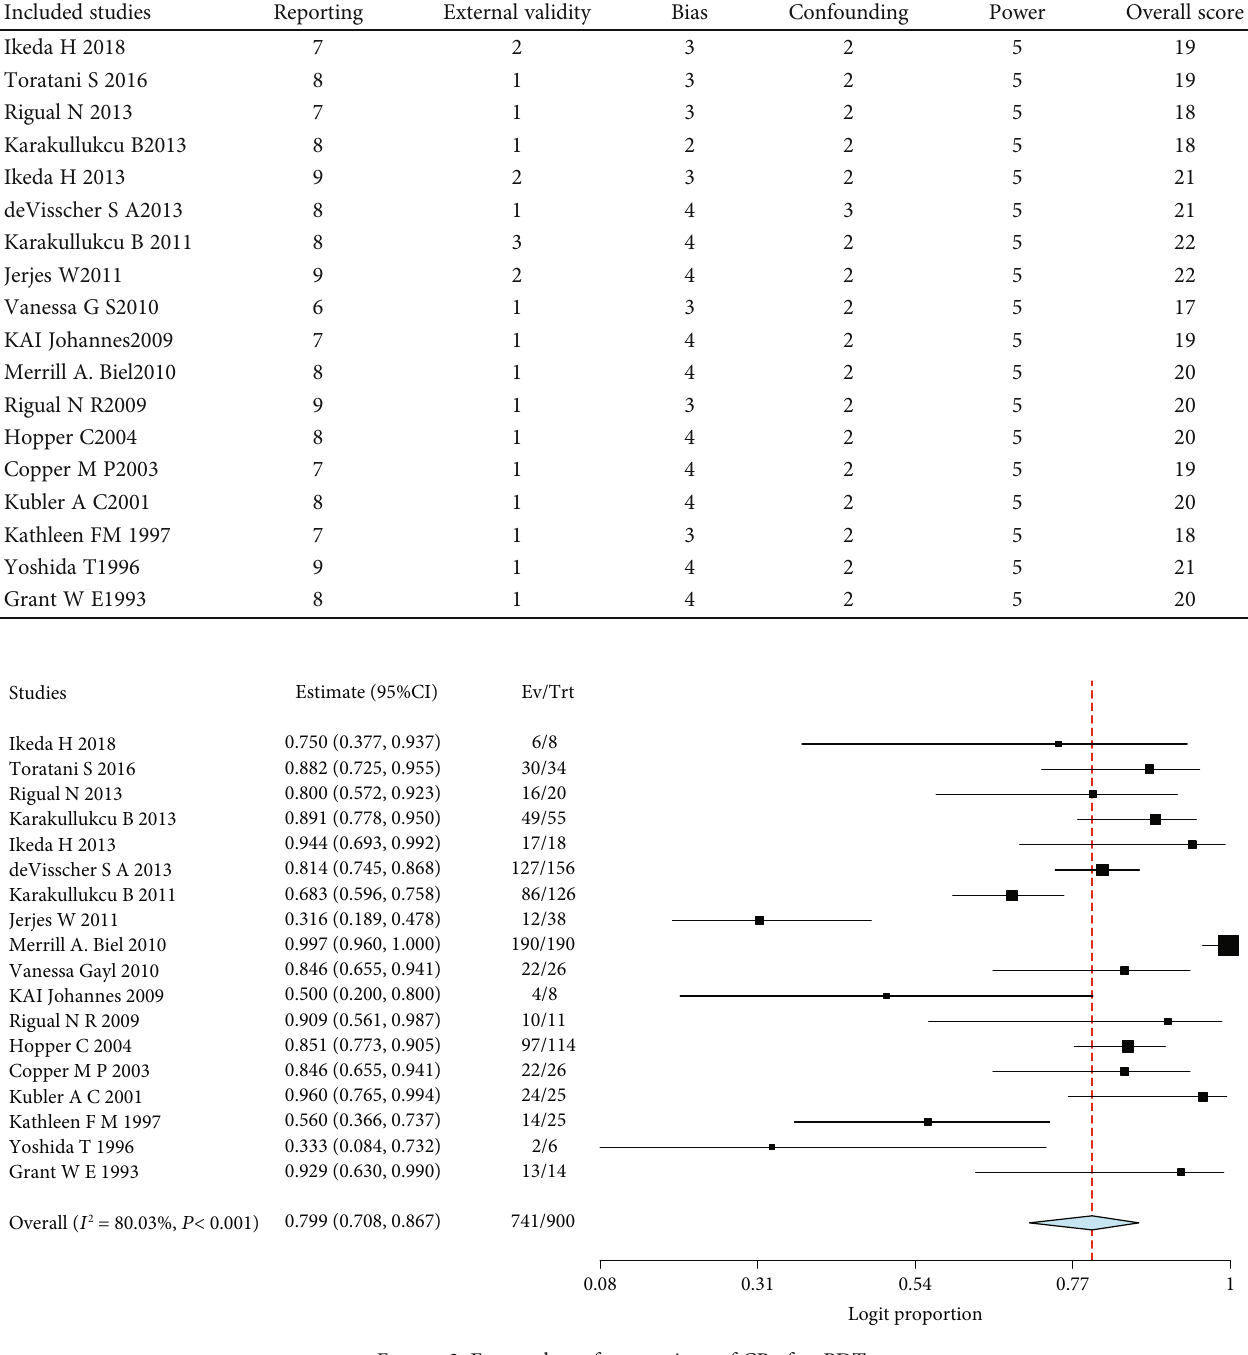
Figure 2: Forest plots of proportions of CR after